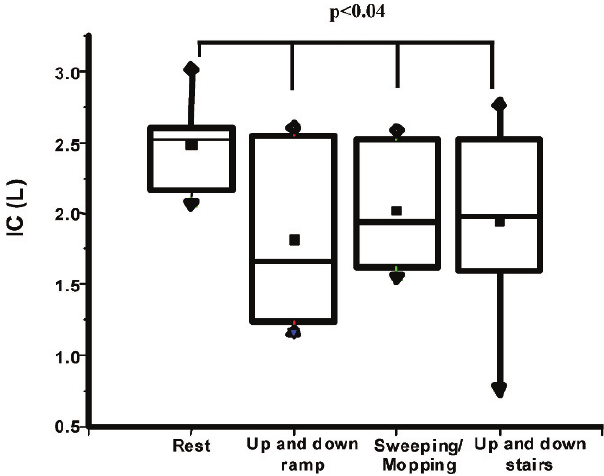
Figure 1 - Boxplot of resting and post-activity (walking up and down a ramp, sweeping/mopping and walking up and down stairs) inspiratory capacities in COPD patients. Data are presented as medians ¡ maximum/minimum